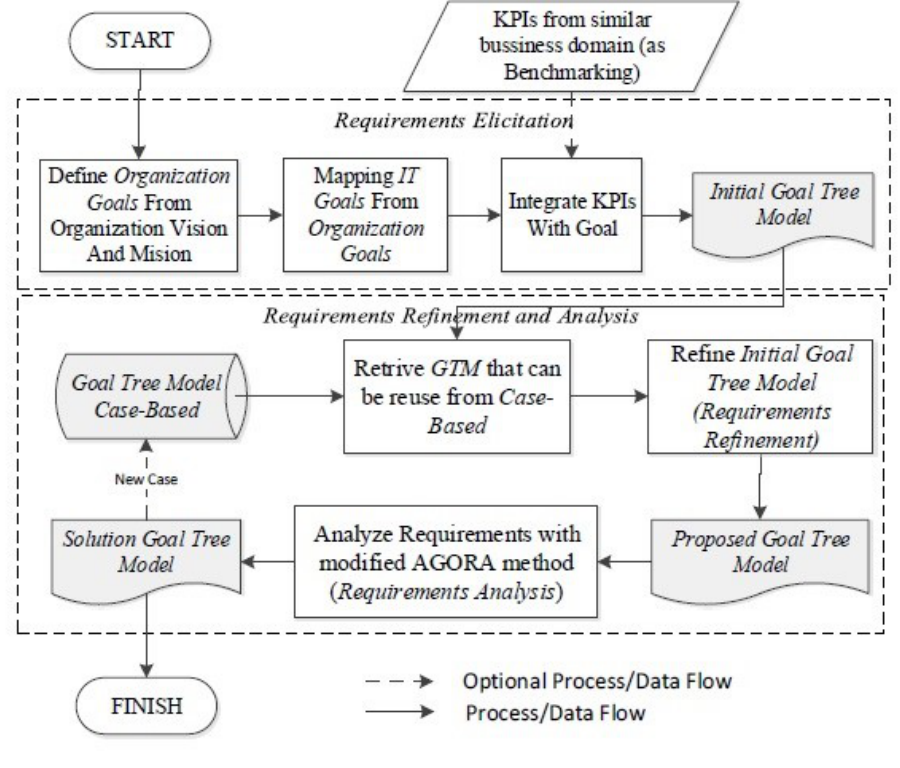
Figure 1: OGORE Steps